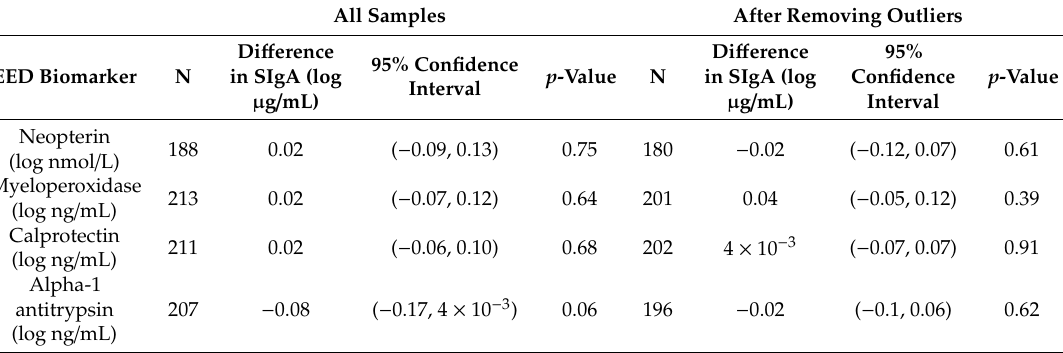
Table 3. Di ff erence in salivary SIgA for a unit di ff erence in environmental enteric dysfunction (EED) biomarker concentration found in stool, after controlling for age, sample volume, 30-day rainfall, and number of concurrent infections. All Samples After Removing